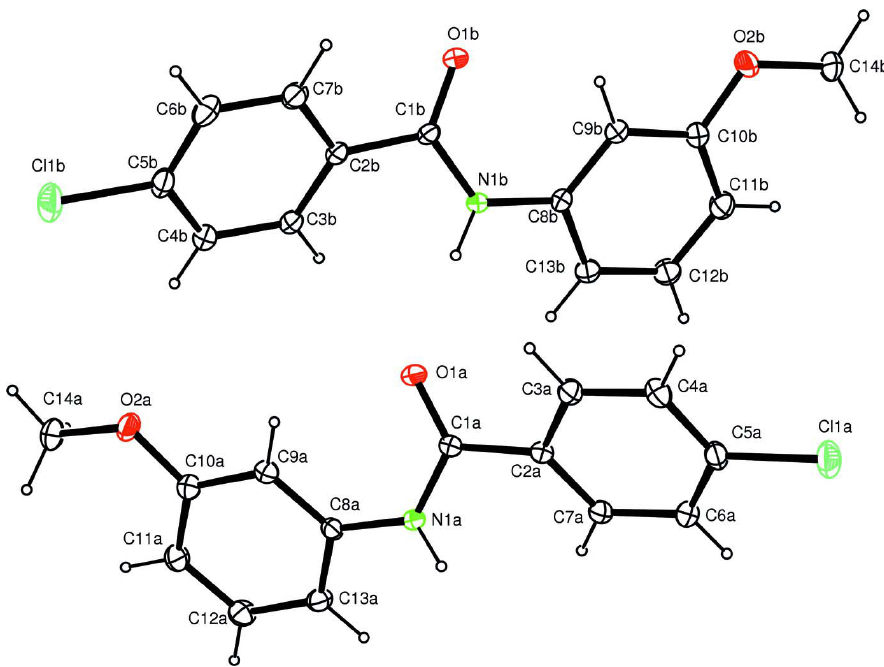
Figure 1 The asymmetric unit of (I) with displacement ellipsoids for the non-hydrogen atoms drawn at the 50% probability level.